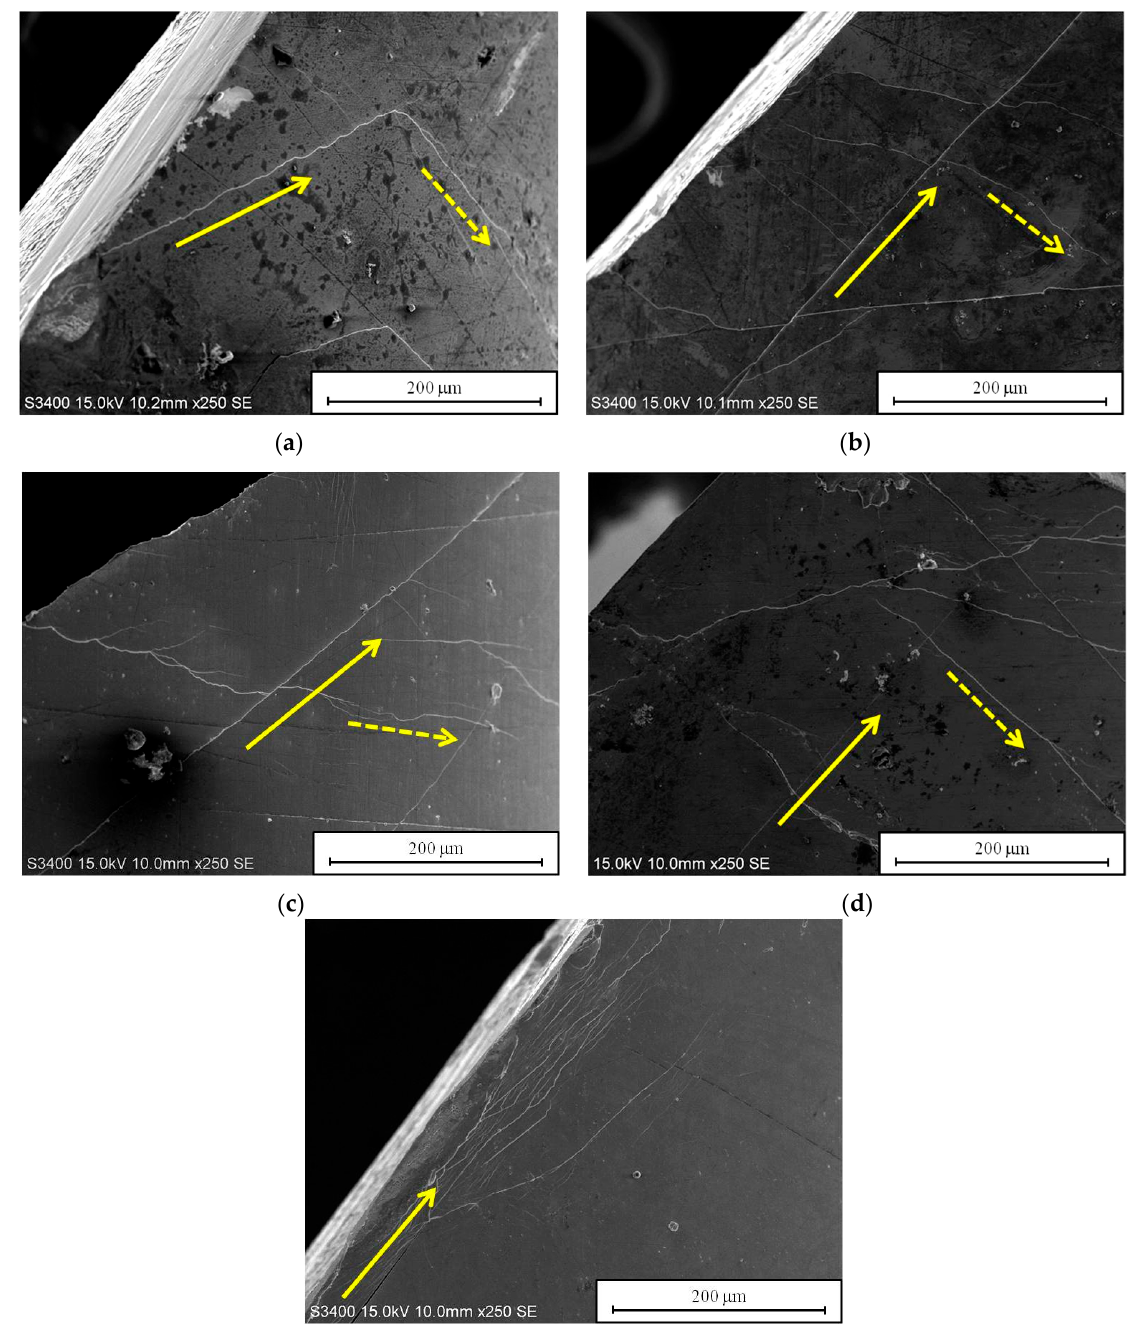
Figure 6. SEM images of the multiple shear bands on the lateral surface of compressive Cu 50 − x Zr 43 Al 7 Ag x alloys: ( a ) x = 0, ( b ) x = 3, ( c ) x = 4, ( d ) x = 5, and ( e ) x = 6. The two arrows indicated the primary shear bands and the secondary shear bands (the arrow with dashed line).